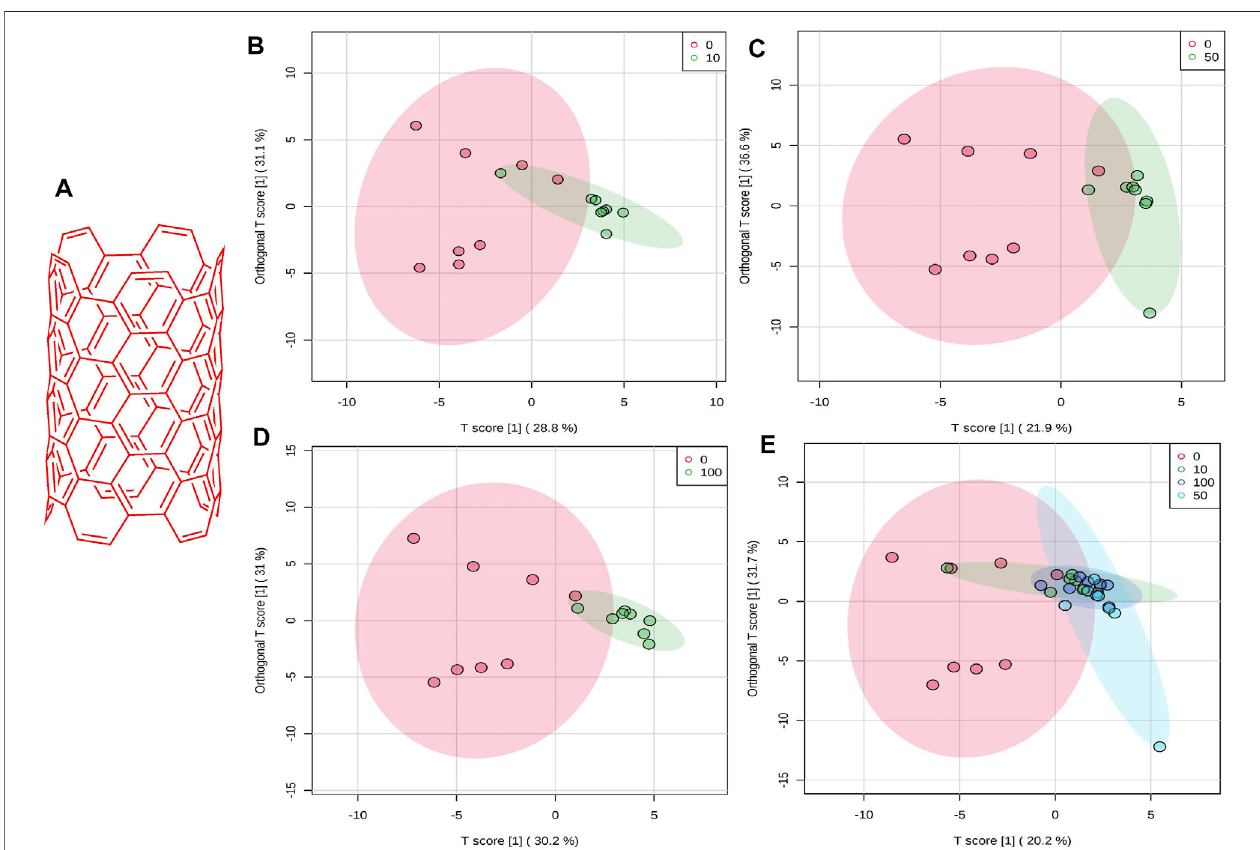
FIGURE1|(A) SchematicchemicalstructureofSWCNT.AnOPLS-DApredictivemodelofzebra fi shmetabolitepro fi lesafterSWCNTsexposure. (B) 0vs10 mg/L, 59.9%,Red dot, 0 mg/L; Green dot, 10 mg/L. (C) 0vs50 mg/L,58.5%, Reddot, 0 mg/L; Greendot, 50 mg/L. (D) 0vs 100 mg/L, 61.2%, Reddot, 0 mg/L;Greendot, 100 mg/L. (E) OPLS-DA score plot on normalized metabolite concentrations of 0 vs 10, 50, 100 mg/L. PC can be found in 51.9% of discriminations. Red dot, 0 mg/L; Green dot, 10 mg/L; light blue, 50 mg/L; and dark blue, 100